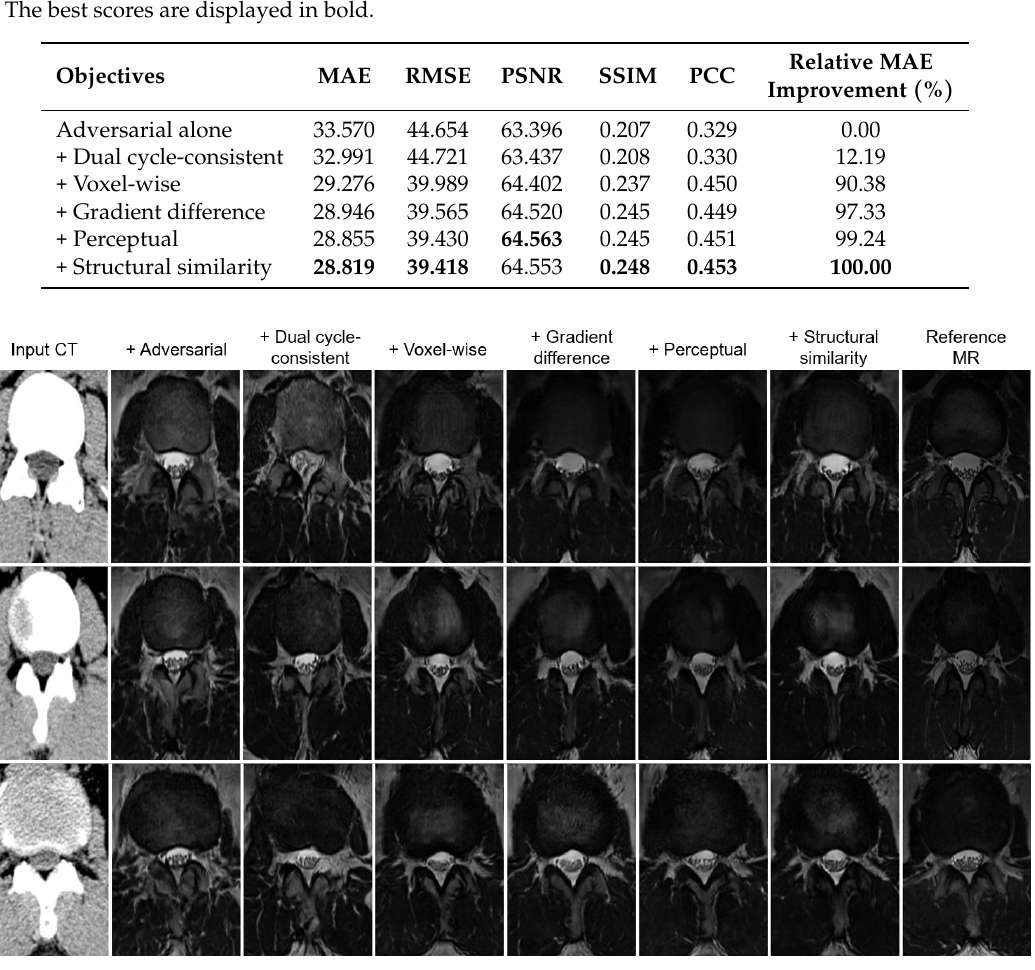
Figure 5. Ablation analysis of the proposed method. From left to right: the input CT, adversarial loss alone, the addition of dual cycle-consistent loss, the addition of voxel-wise loss, the addition of gradient difference loss, the addition of perceptual loss, the addition of structural similarity loss, and the reference MR